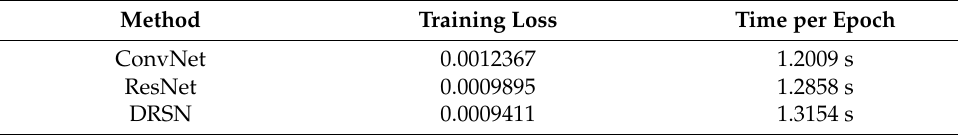
Table 4. The training loss and the training time for different methods.